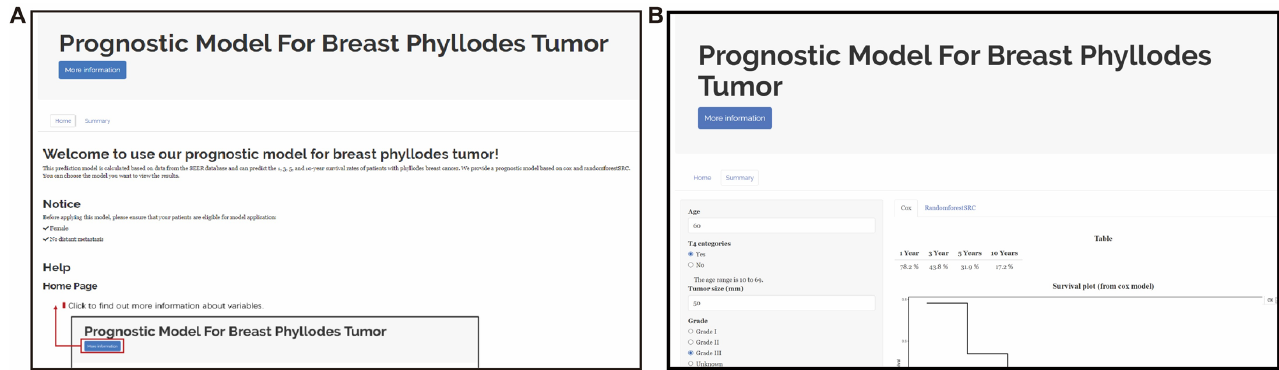
Figure 5. Screenshot of web app. ( A ) Screenshot of the home page of our shiny app. ( B ) Screenshot of the summary page of our shiny app. of the summary page of our shiny